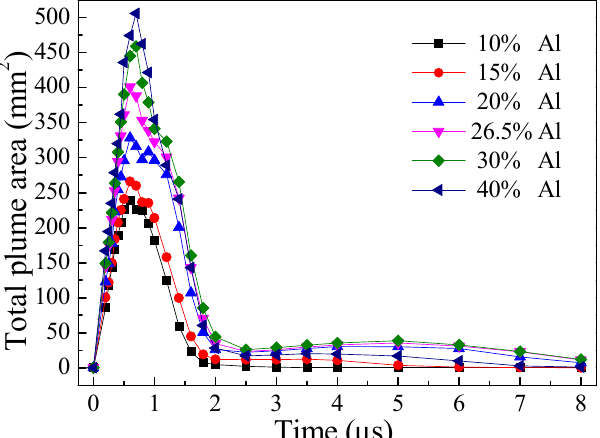
Figure 10. The total plume area variation with time at different proportions of Al (ambient pressure 0.005 Pa and laser energy 542.3 mJ).